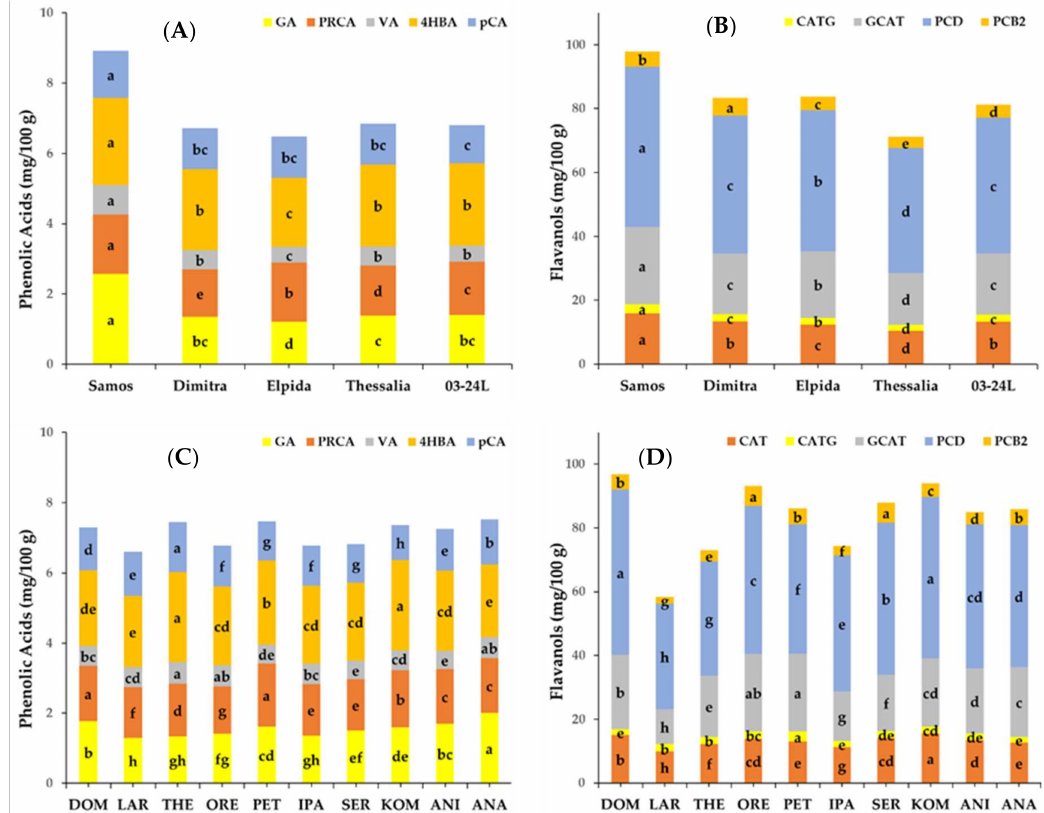
Figure 1. Quantification of individual phenolic acids ( A , C ) and flavanols ( B , D ) in lentil seeds for genotypes (Samos, Dimitra, Elpida, Thessalia and 03-24L) and locations (DOM, Domokos; LAR, Larissa; THE, Thessaloniki; ORE, Orestiada; PET, Petrana; IPA, Ipato; SER, Serres; KOM, Komotini; ANI, Agioi Anargiri; ANA, Anatoliko) tested (Phenolic compounds: GA, gallic acid; PRCA, protocatechuic acid; VA, vanillic acid; 4HBA, 4-hydroxybenzoic acid; pCA, p-coumaric acid; CAT, catechin; CATG, catechin gallate; GCAT, gallocatechin; PCD, procyanidin dimer I; PCB2, procyanidin B2). Bars followed by the same letter in the same assay are not significantly different ( p ≤